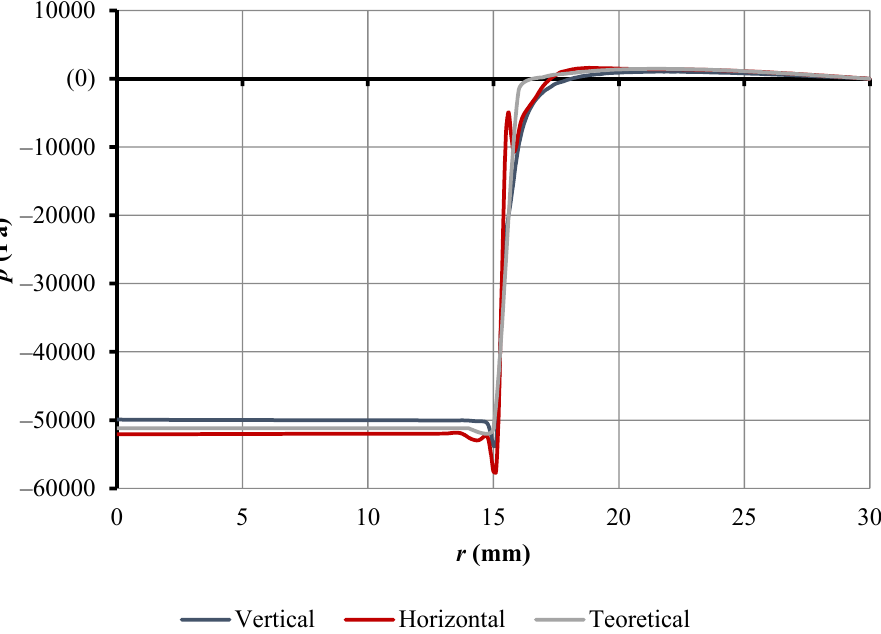
Figure 6. Pressure distribution on the surface of the object of manipulation in different directions of compressed air supply.